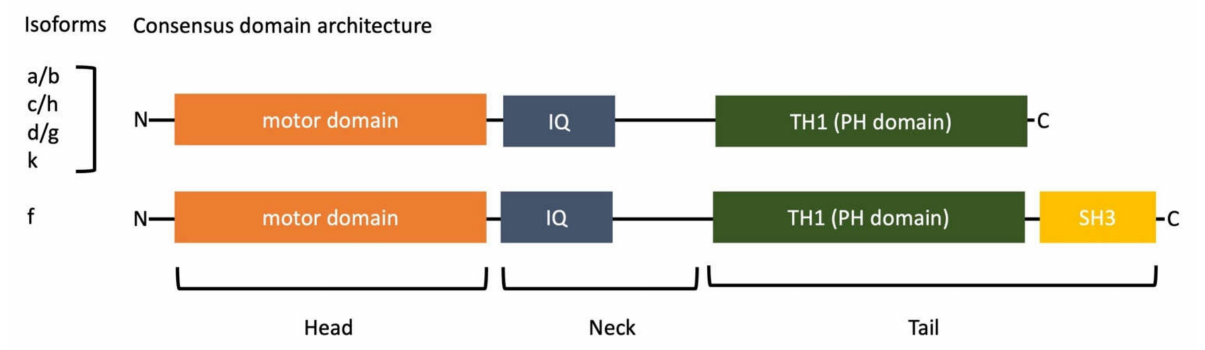
Figure 1. Characteristic protein domain organization of class 1 myosins modified from